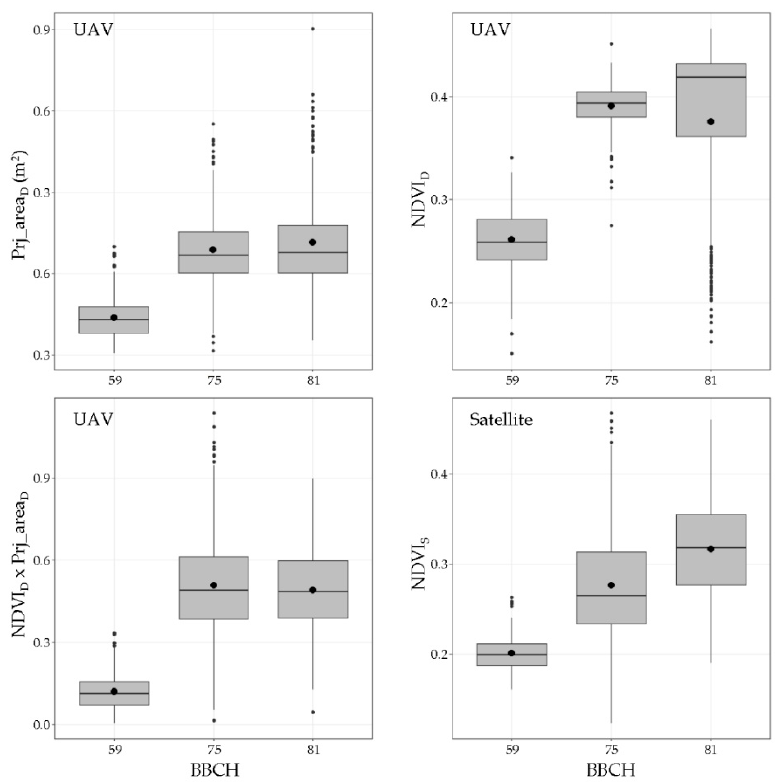
Figure 6. Box plots of principal descriptive statistical parameters for remote sensing variables. ● mean values.